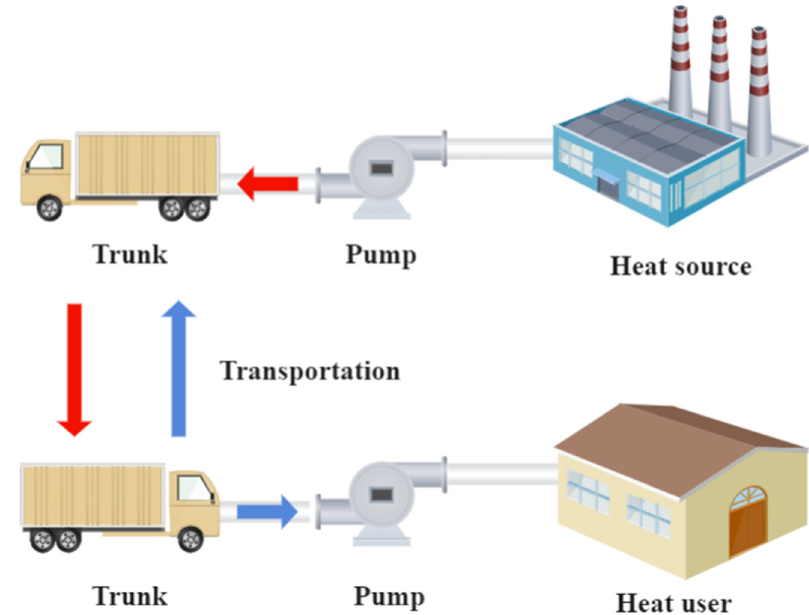
Figure 1. Concept of a mobilized heat storage system (MHSS).